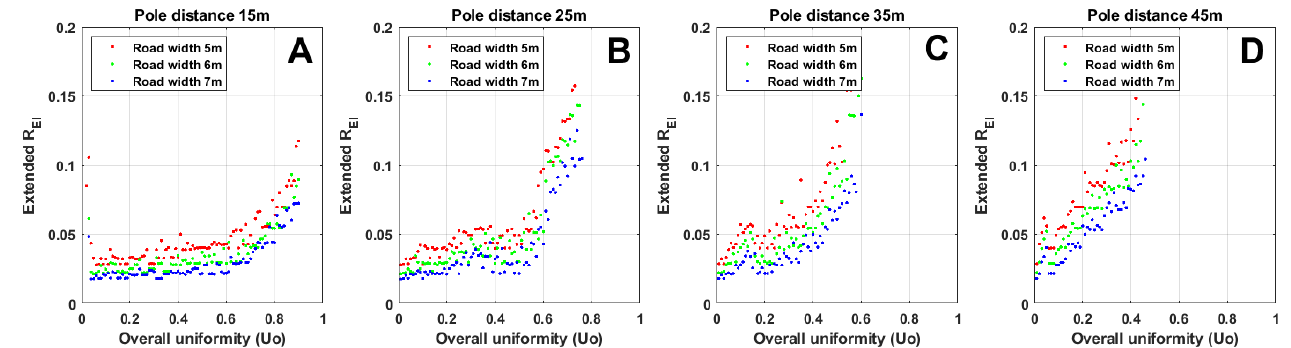
Figure 14. Overall uniformity of illuminance vs. minimum extended R EI for key pole distances. Only R EI ≤ 0.2 is included: ( A ) results for pole distance of 15 m; ( B ) results for pole distance of 25 m; ( C ) results for pole distance of 35 m; ( D ) results for pole distance of 45 m.